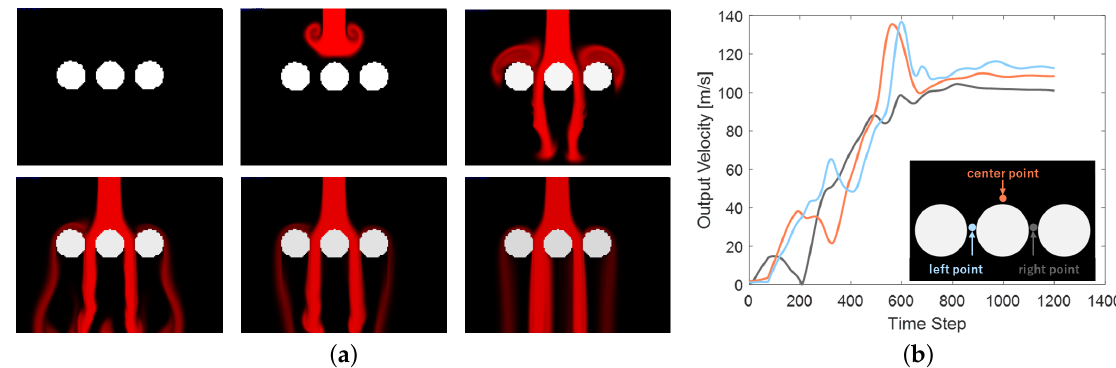
Figure 4. ( a ) Fluid simulation for 3 fingers and ( b ) the velocity measured in the fluid simulation on the left, center, and right parts of the middle finger.